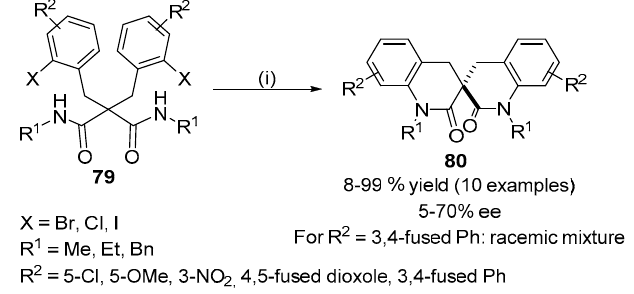
Scheme 24. Synthesis of spirobis[3,4-dihydroquinolin-2(1 H )-ones] 80 by intramolecular double N